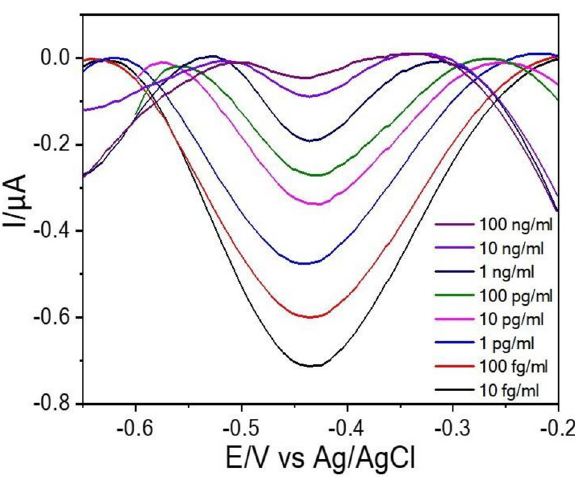
Figure 3. DPV responses obtained for the immunosensor at various concentration of free